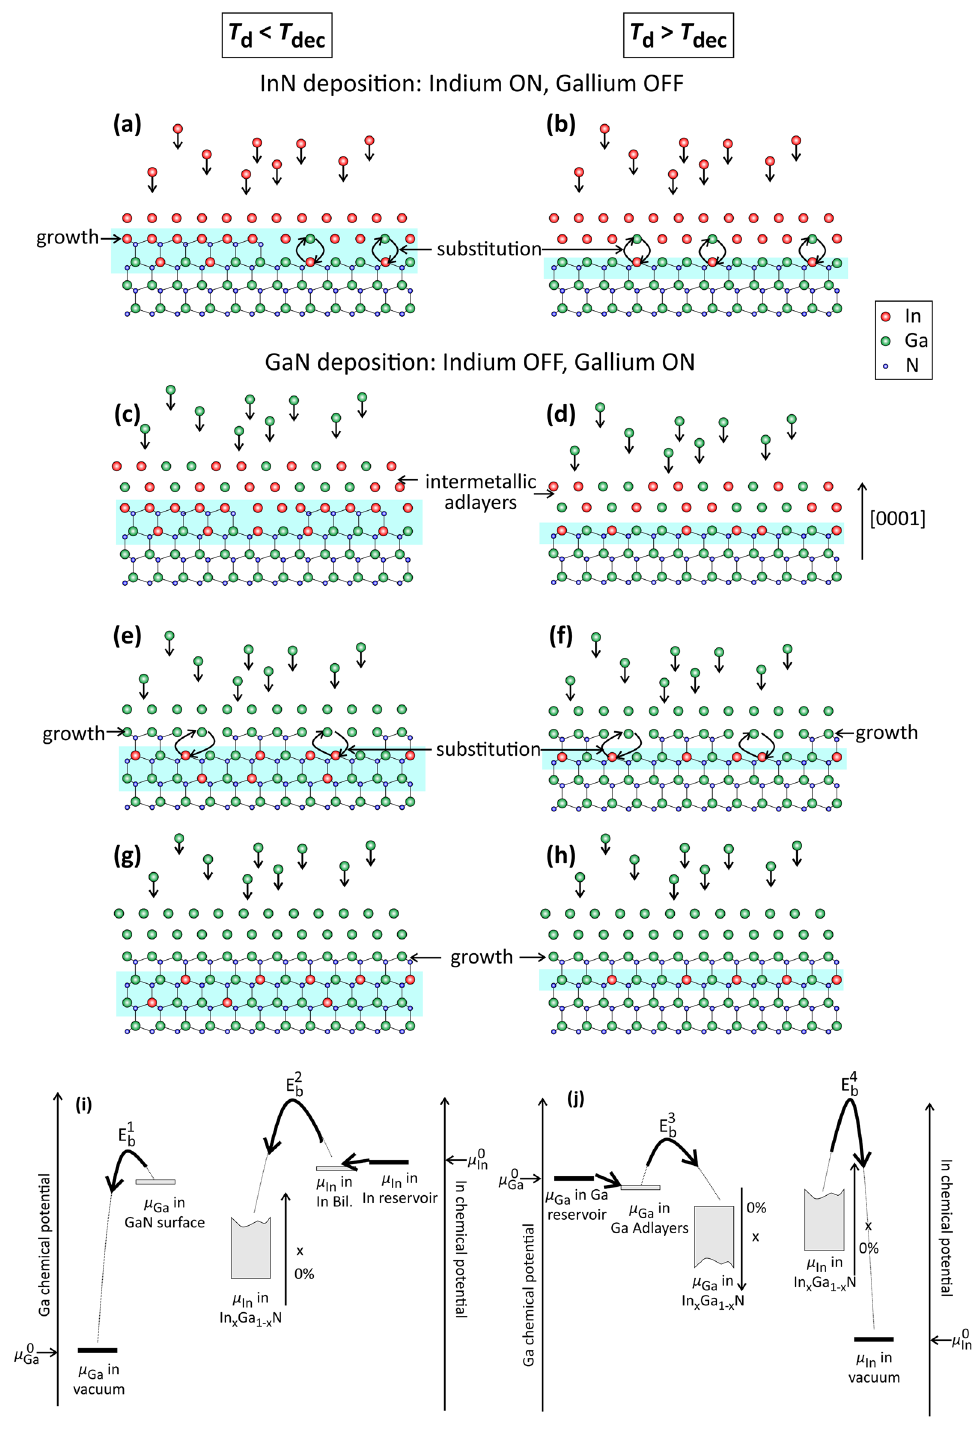
Figure 7. ( a–h ) Schematic representation of the synthesis of In x Ga 1− x N/GaN MQWs. In the left (right) figures, the deposition temperature is lower (higher) than the decomposition temperature, respectively. ( a,b ) InN deposition stage. ( c–h ) GaN deposition stage. The ball-and-stick models are in cross-sectional view and the color code is as in Fig. 4. The blue-shaded areas indicate the position of the QW. ( i,j ) Schematic representation of gallium and indium chemical potentials in the InN and GaN deposition stages, respectively. The black bars indicate the boundaries of indium and gallium chemical potentials imposed by the growth conditions, µ µ 0 Ga , respectively. Under thermodynamic equilibrium, µ Ga and µ In at the surface or in In 0 0 to µ Ga and µ In , respectively. µ Ga and µ In in In x Ga 1− x N depend on the indium content x : µ In ( µ Ga ) increases i i =1…4) denote kinetic barriers for indium and gallium atoms to move from (decreases) with x , respectively. E b ( the metastable to the stable